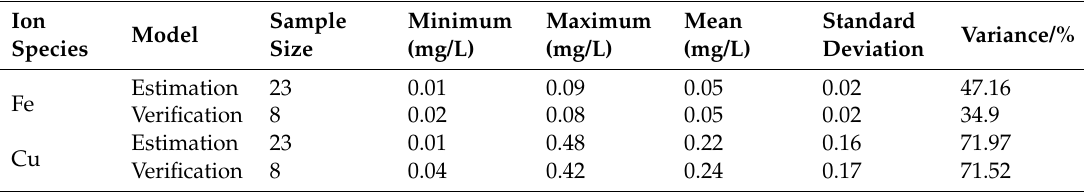
Table 2. Data statistics of the Fe and Cu content estimation